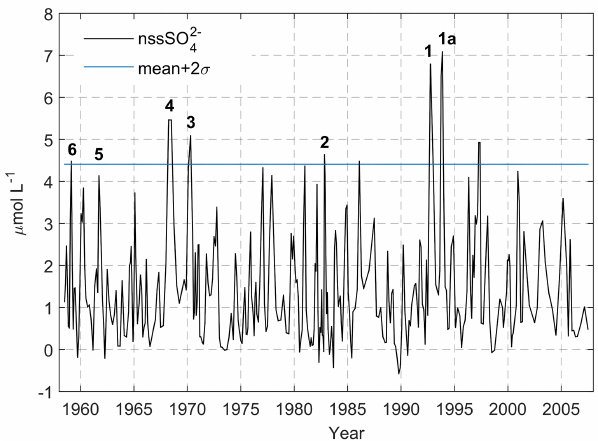
Figure 4. Non-sea-salt SO 2 − concentrations measured in KC, us- 4 ing the timescale derived from annual layer counting in the δ 18 O profile. Potential layers of volcanic eruptions are marked with num- bers: 1, 1a (Pinatubo), 2 (El Chichón), 3, 4 (Deception Island), 5 (Agung, Indonesia; Puyehue, Chile), 6 (Caran-Los Vernados, Chile) and summarised in Table